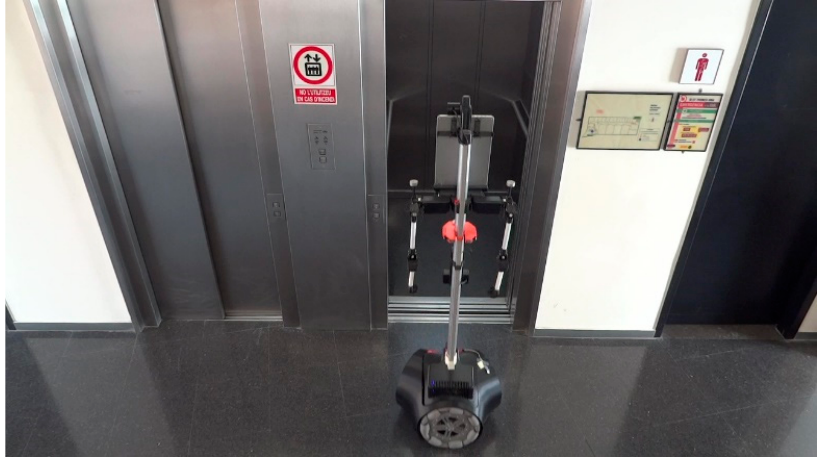
Figure 17. APR ‐ 02 mobile robot calling the elevator through the IoT device for elevator control.